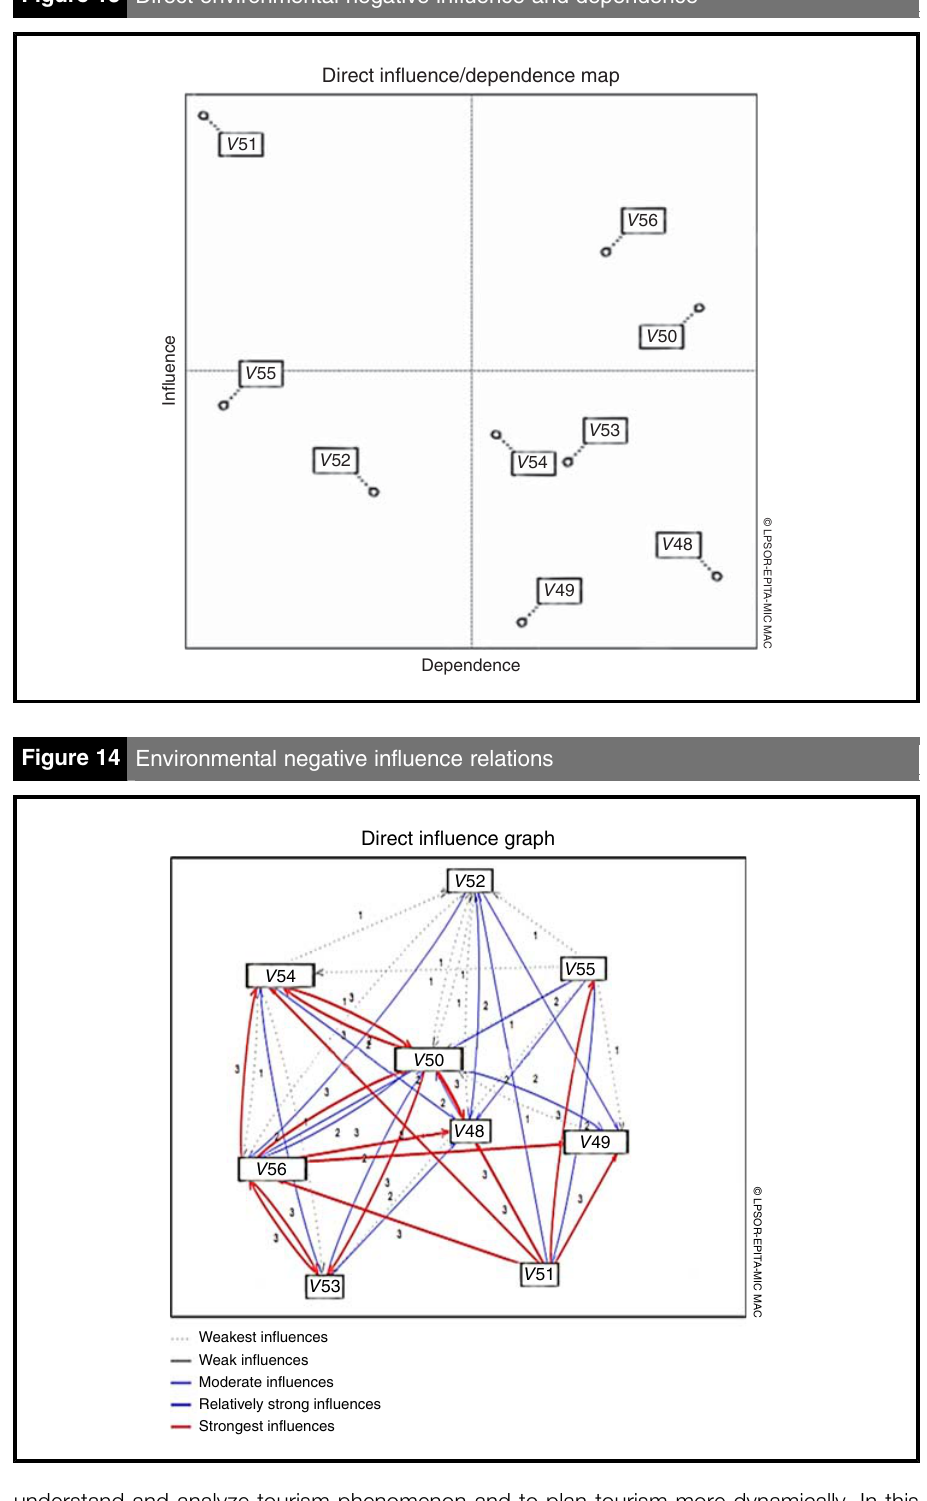
Figure 13 Direct environmental negative influence and dependence